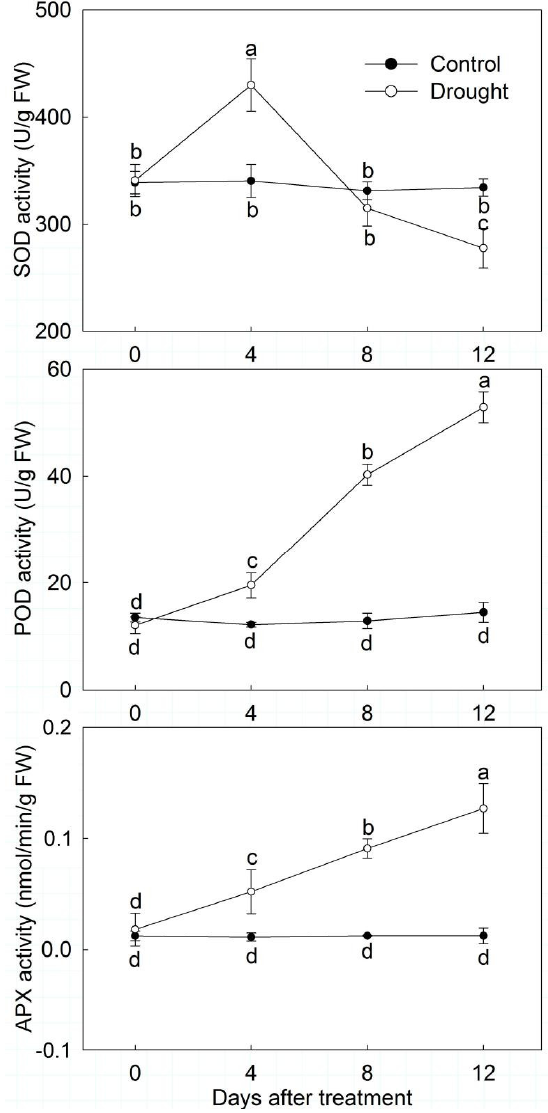
Figure 3. Protective enzyme activity changes of drought-treated P. ostii and the control. Values represent mean ± standard deviation (SD), and letters indicate significant differences according to Duncan’s multiple range test ( p <0.05). SOD, superoxide dismutase; POD, peroxidase; APX, ascorbate peroxidase.